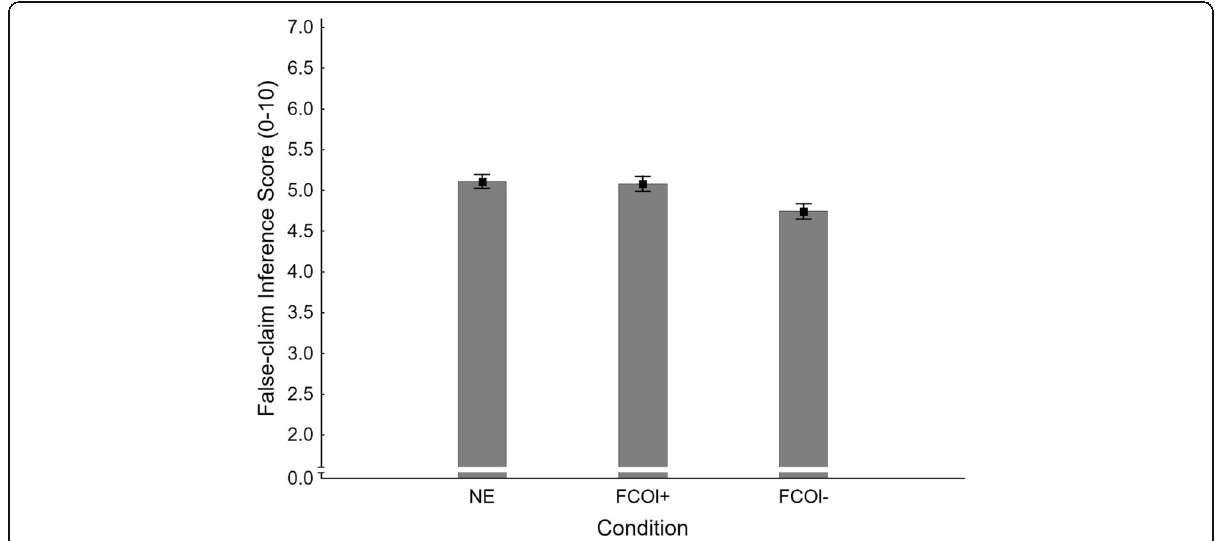
Fig. 12 Mean false-claim inference scores across conditions NE (no-exposure) and FCOl± (fact-check-only, with/without cognitive load) in Experiment 3. Error bars show standard errors of the